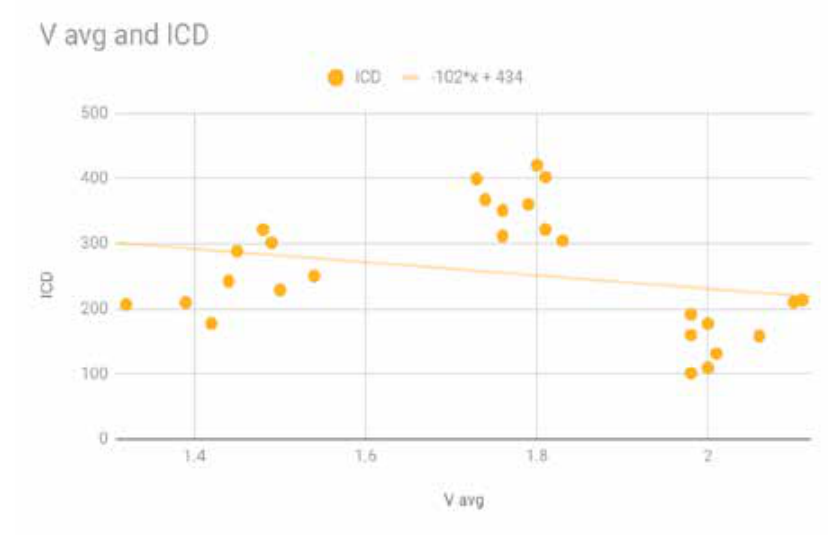
Fig. 2. Correlation diagram of Vavg (average swimming speed) and ICDI (intra cycle dynamic